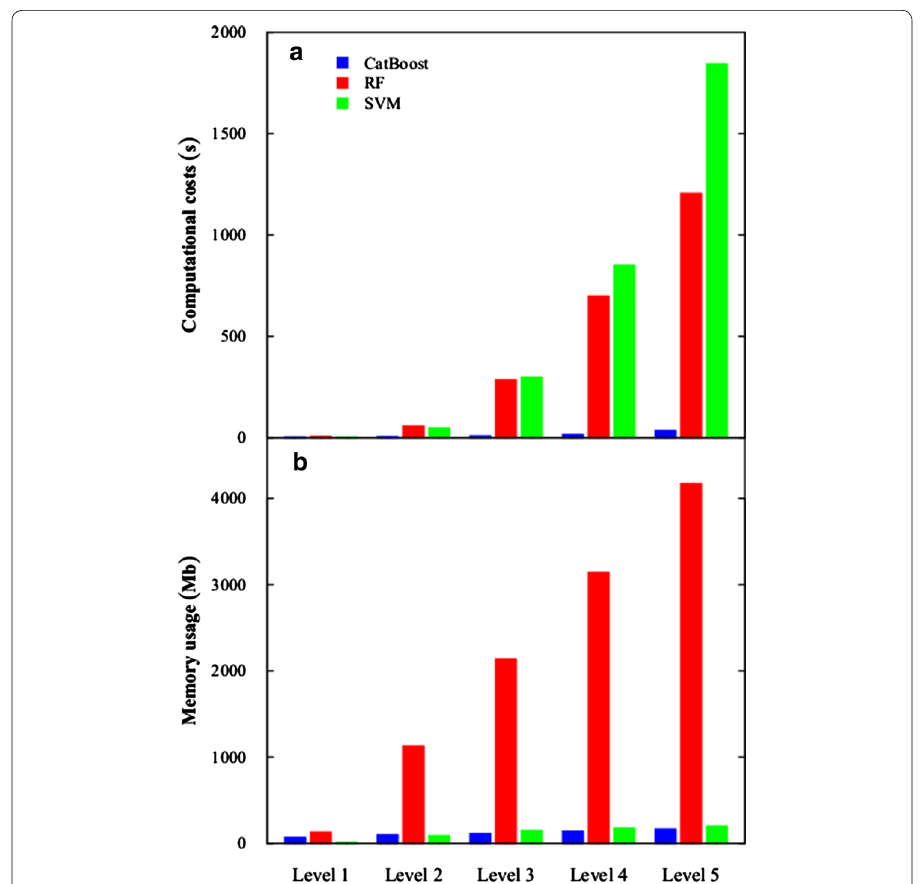
Fig. 6 Image from [33] illustrating the relative efficiency of CatBoost, according to Huang et al. Level 1 is 10 years’ data from a single station, Level 2 is 10 years’ data from 12 stations, Level 3 is 20 years’ data from 12 stations, Level 4 is 30 years’ data from 12 stations and Level 5 is 40 years’ data from 12